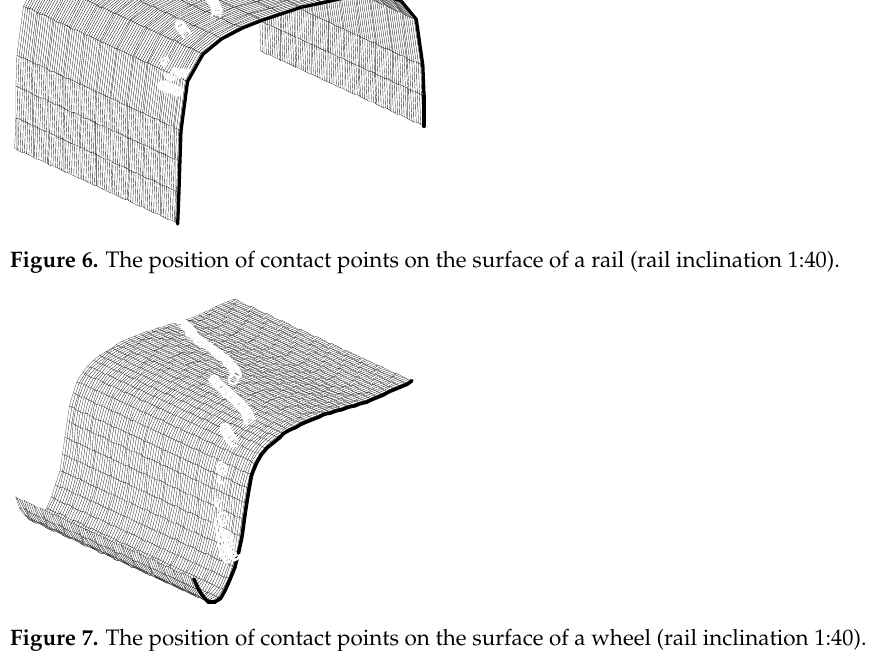
Figure 8. The position of contact points on the surface of the rail (rail inclination = 0).